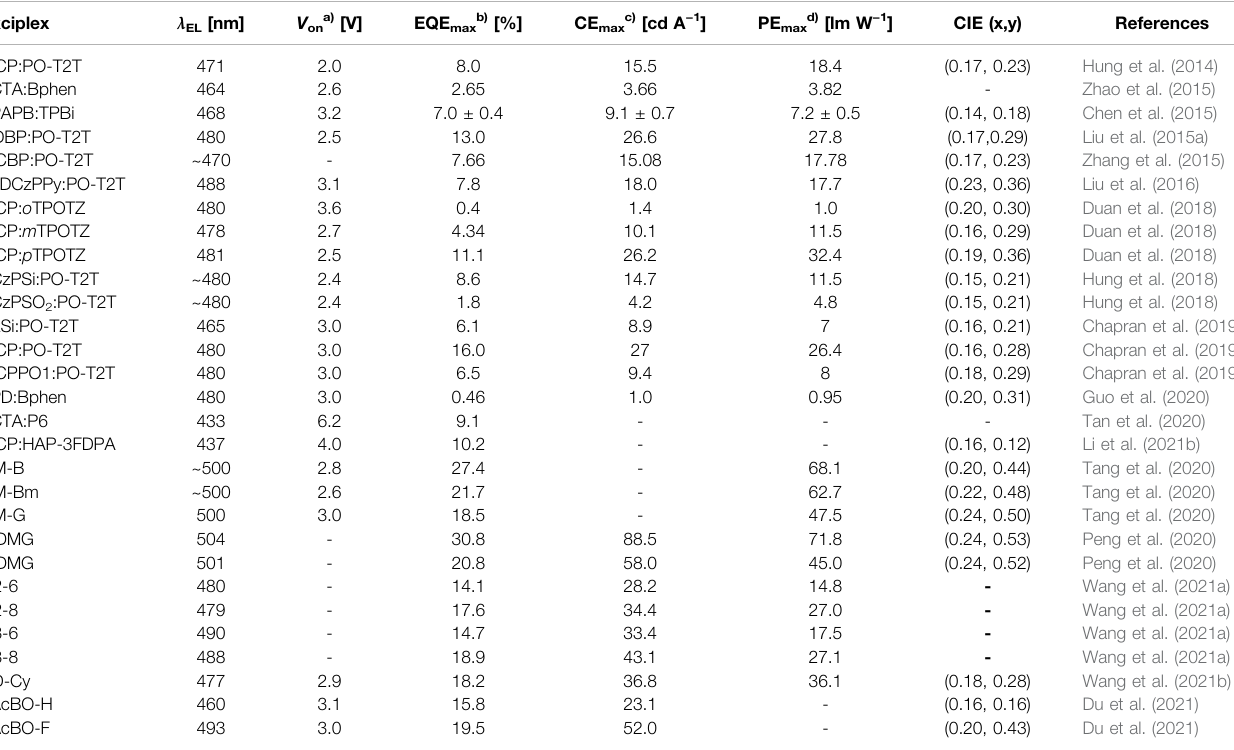
TABLE 1 | Electroluminescence performance of blue exciplex – based organic light-emitting diodes.